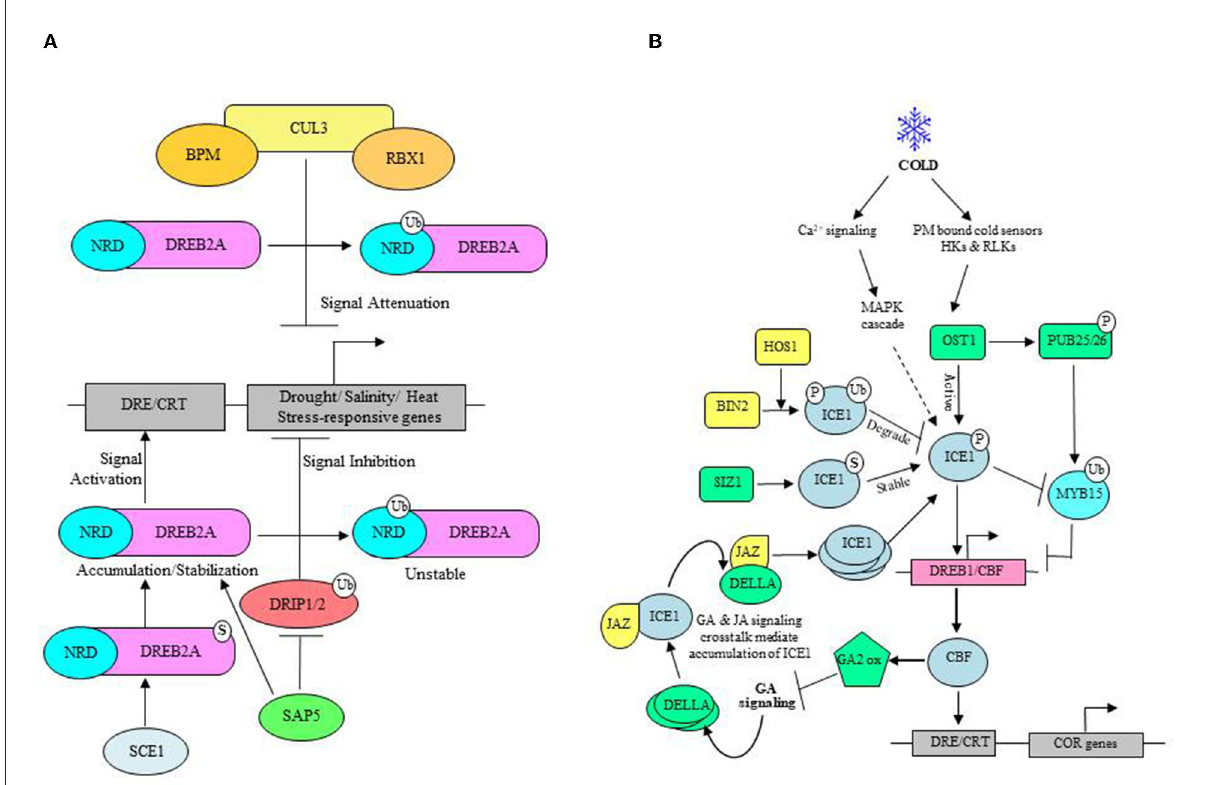
FIGURE4 ABA-independent stress response. (A) Under drought and salt stress: DREB2A transcription factor functions upstream of various drought, salt, and heat-responsive genes. DRIP1/2 E3 ligase negatively regulates stress tolerance as a signaling inhibitor and targets DREB2A for UPS-mediated degradation. SAP5 E3 ligase reinforces stress signaling by regulating DRIP1/2 turnover. SCE1-mediated SUMOylation of DREB2A also enhances its stability. CUL3-based BPM ligases mark DREB2A for degradation as a signal attenuator. (B) Under cold stress: Cold stimulus